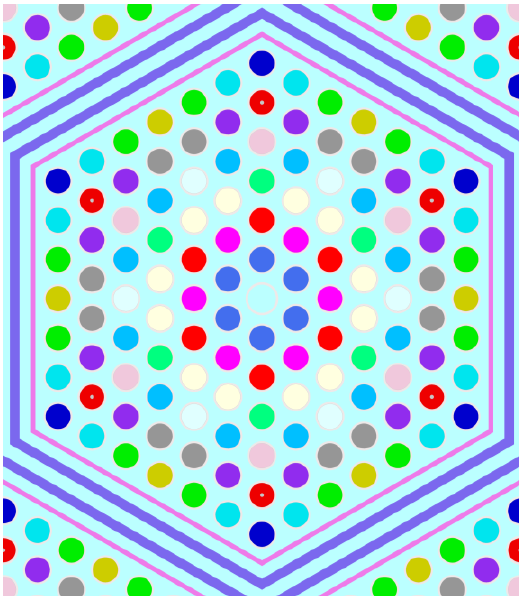
Fig. 1. Detail of fuel assembly in spent fuel pool calculation model.